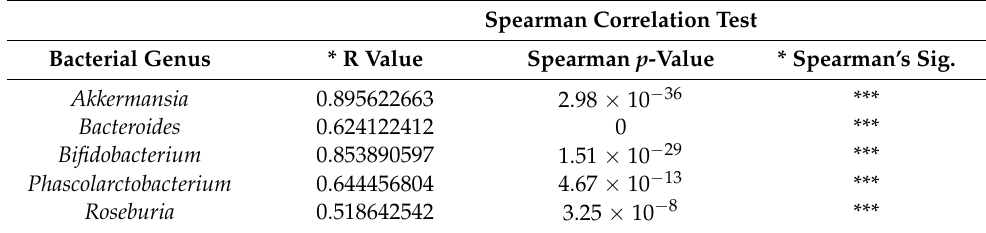
Figure 4. Spearman correlation scatter plot showing the relationship of each bacterial relative propor- tion value measured by qRT-PCR assay and 16S V3-V4 metagenome sequencing data; *** = Spearman p -value < 0.001, R = Spearman’s rho value. Table 3. Statistical result of the Spearman correlation test between two different quantification